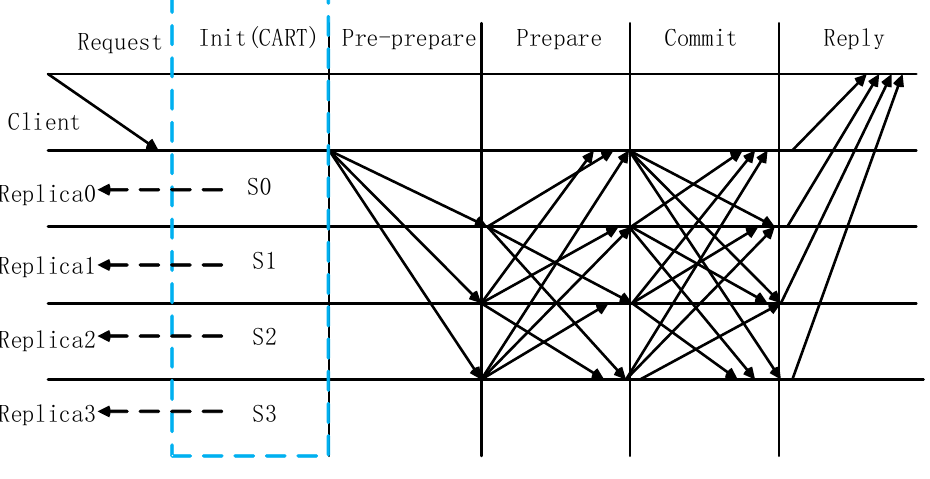
Figure 3. Optimized PBFT algorithm consensus process.